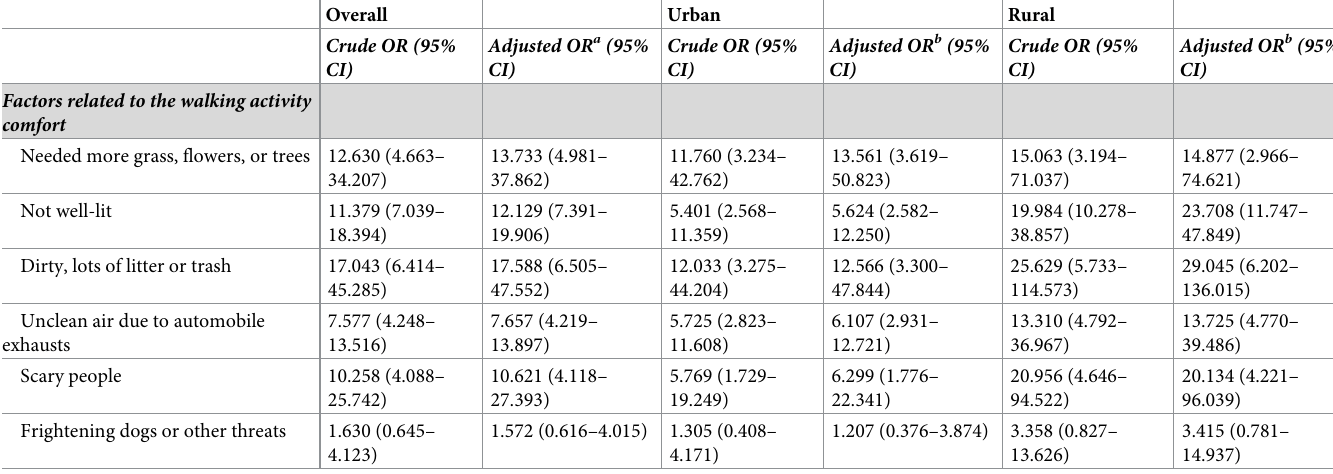
Table 4. Odds ratios for the dissatisfaction with the walking-related environments according to the factors associated with the walking activity comfort.